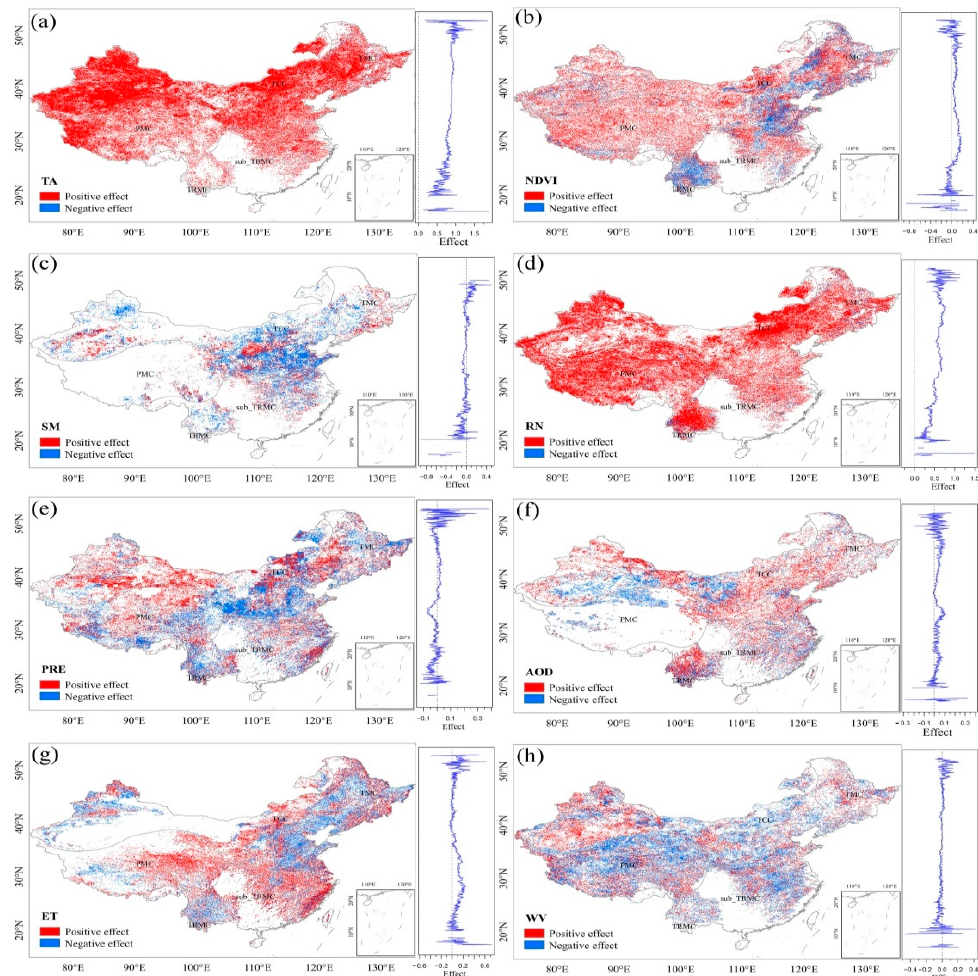
Figure 13. Spatial and latitudinal distribution of the direction of the effect ( Δ LST/ Δ factor) of each driver on LST. ( a ) TA ( b ) NDVI ( c ) SM ( d ) RN ( e ) PRE ( f ) AOD ( g ) ET ( h ) WV. For the spatial distribution panel the red areas indicate a positive effect ( ∆ LST/ ∆ factor > 0) on LST, while the blue areas indicate a negative effect ( Δ LST/ Δ factor < 0) on LST.